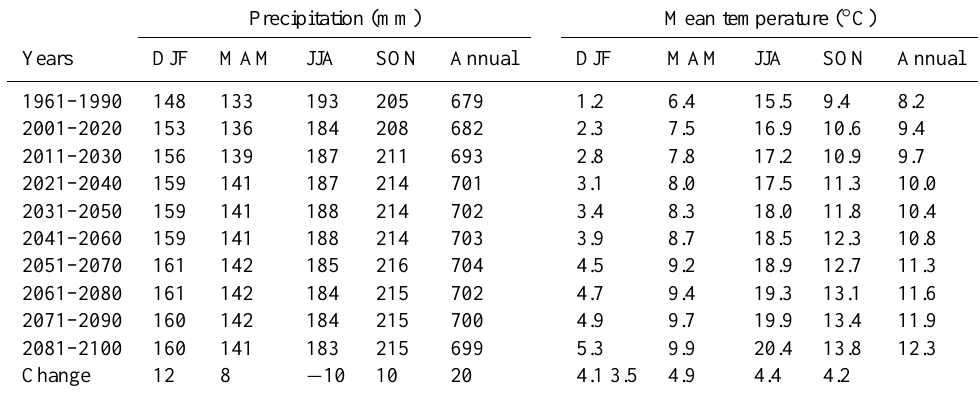
Table 1. Mean seasonal and annual precipitation (mmy − 1 ) corrected to soil surface and mean air temperature ( ◦ C) of the baseline period (1961–1990, which was scaled to the observation period 1982–2005) and the projected climate scenarios obtained for all periods for the study area in Denmark. The change shows the difference between 2081–2100 and